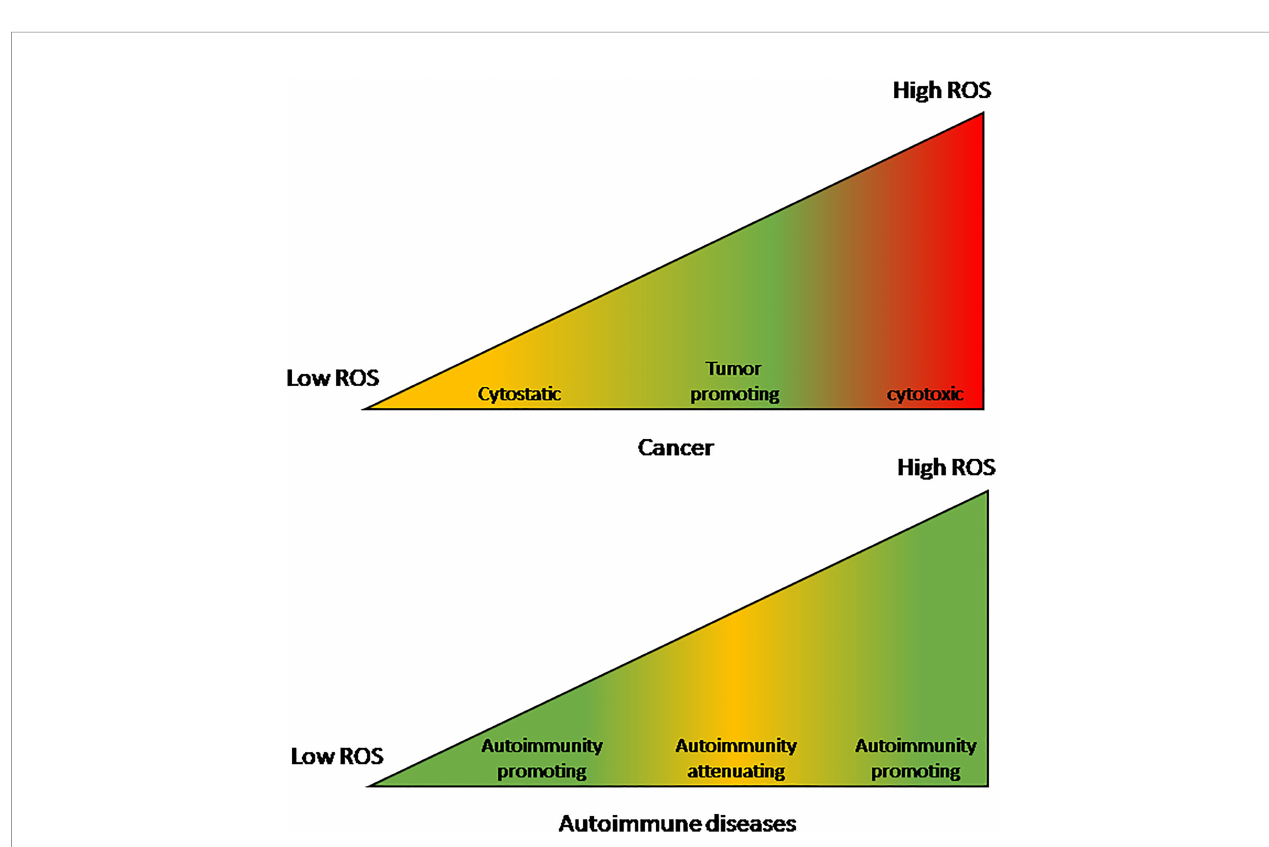
FIGURE 1 | The effect of reactive oxygen species levels on cancers and autoimmune diseases. The effect on cancers is a mirror-image of the effect on autoimmune diseases. Cancers are optimally promoted by moderately-high ROS levels while autoimmune diseases are promoted by either low or very high ROS levels. On the other hand, at moderately-high ROS levels autoimmune diseases are attenuated while very high ROS levels are cancer-cytotoxic and low levels are